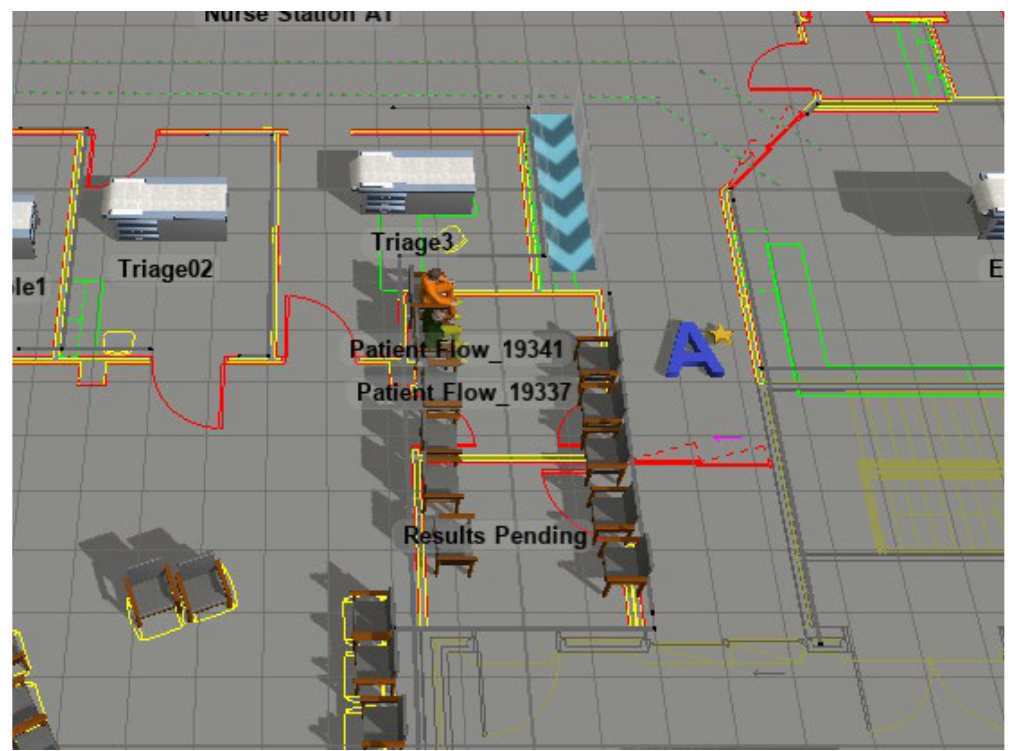
Figure 4 The Results pending area was created in the ED to evaluate its outcome on patient LOS (Image Copyright: